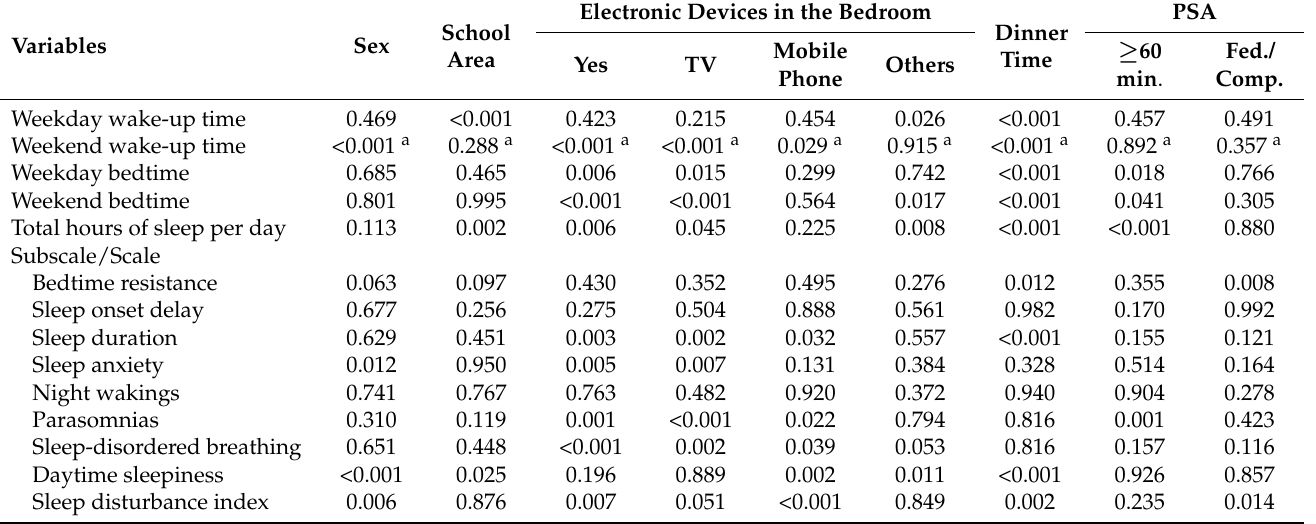
Table 3. p -value of the Mann–Whitney U test (or t -test) for wake-up and bedtime on weekdays and on weekends, total sleep time, and the scores of the CSHQ-PT by sex, area where the school is located (school area), electronic devices present in the bedroom, dinner time before or after 8 p.m. (dinner time), and PSA practice ( ≥ 60 min. = the child accumulates at least 60 min of PSA per day; Fed./Comp. = the child belongs to a sports